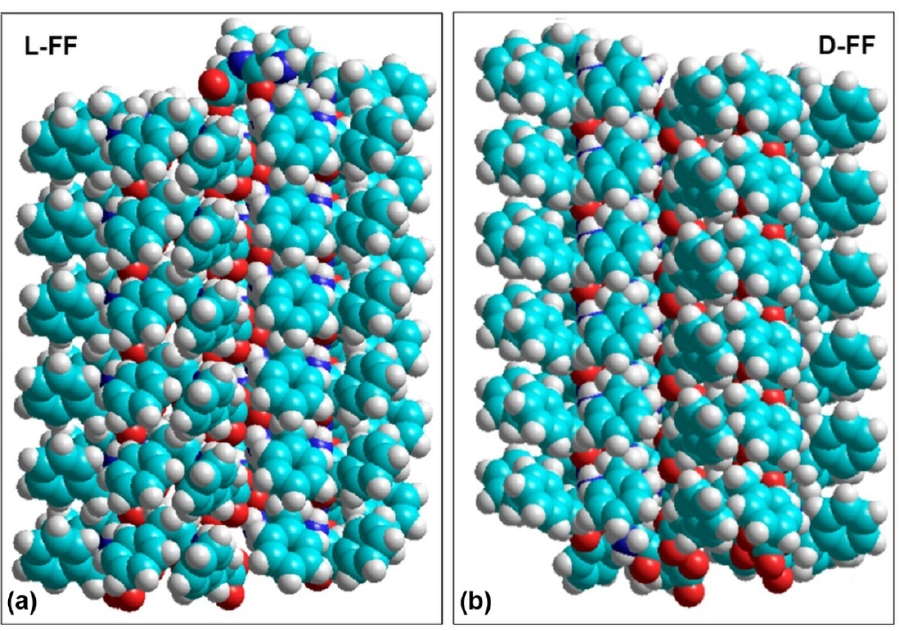
Figure 3. Images of helix-like FF PNTs based on experimental crystallographic data [31,38]: ( a ) L-FF and ( b ) D-FF. L-FF PNT shows right-handed twist, whereas D-FF shows left-handed.